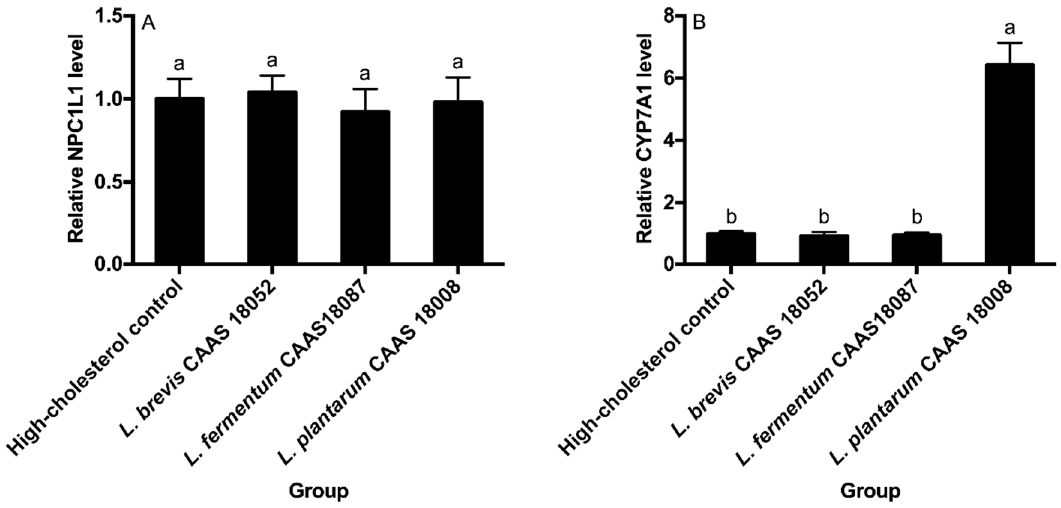
Figure 6. Small intestinal NPC1L1 protein (A) and hepatic CYP7A1 levels of the different groups. Data are represented as the mean ± SD ( n = 8). Means not sharing a common letter differ significantly from each other ( p < 0.05).